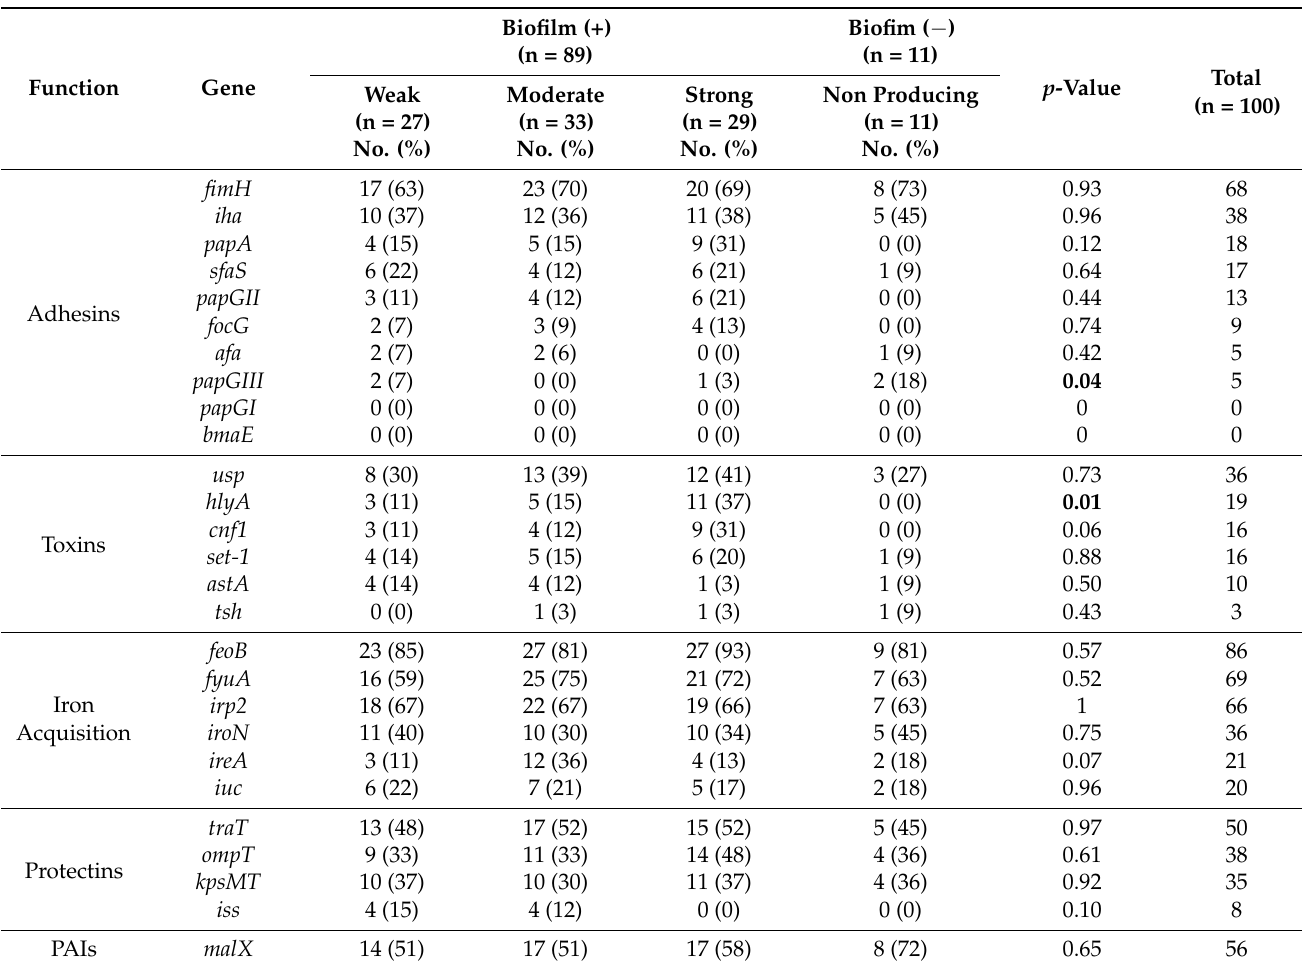
Table 4. Frequency of virulence genes according to biofilm formation in E. coli